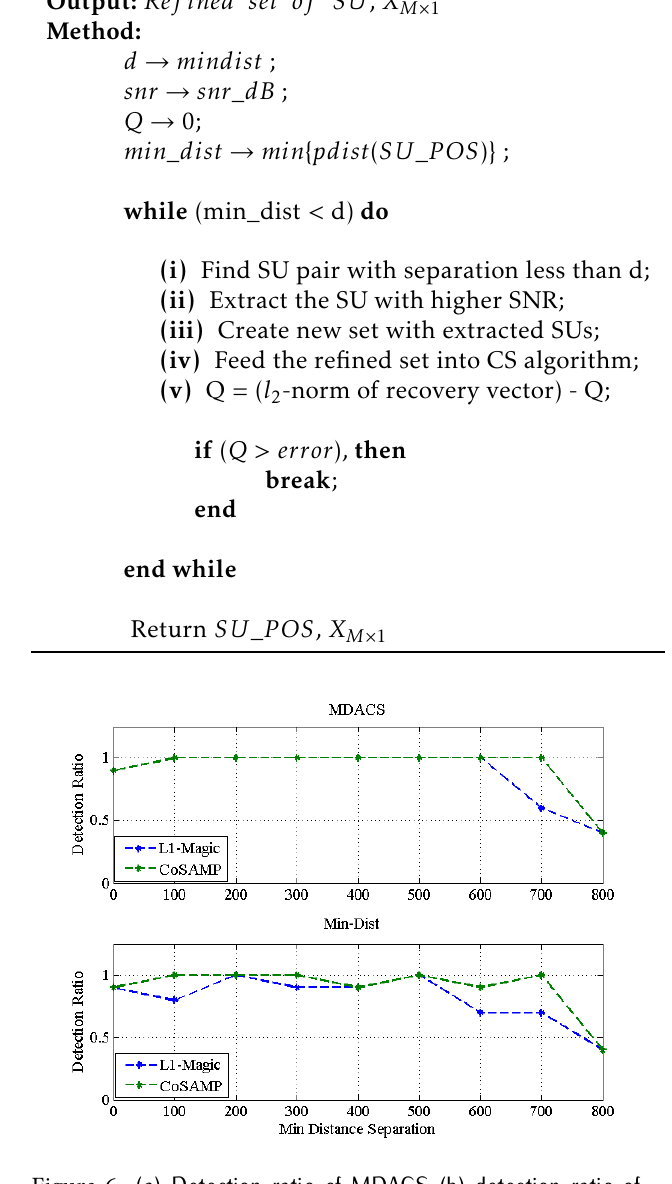
Figure 6. (a) Detection ratio of MDACS (b) detection ratio of existing